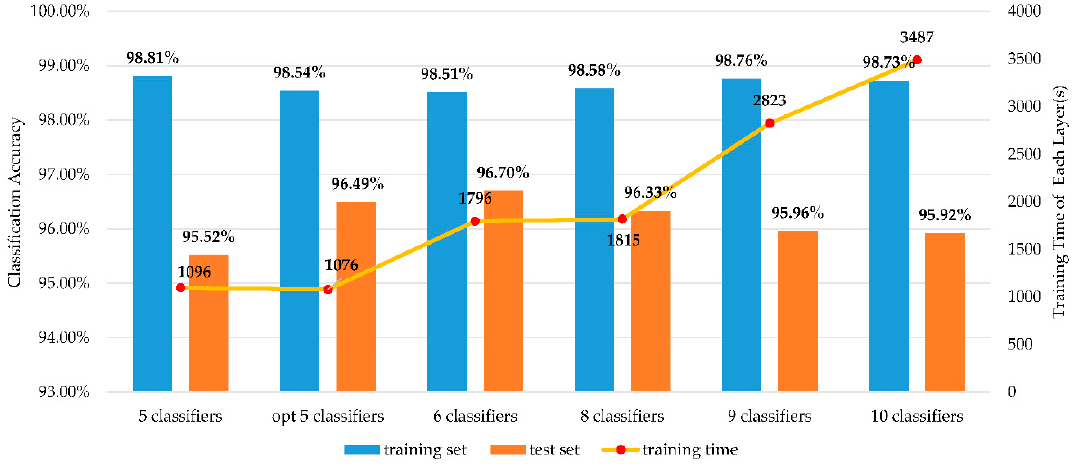
Figure 16. The accuracy and per layer training time of different combinations.